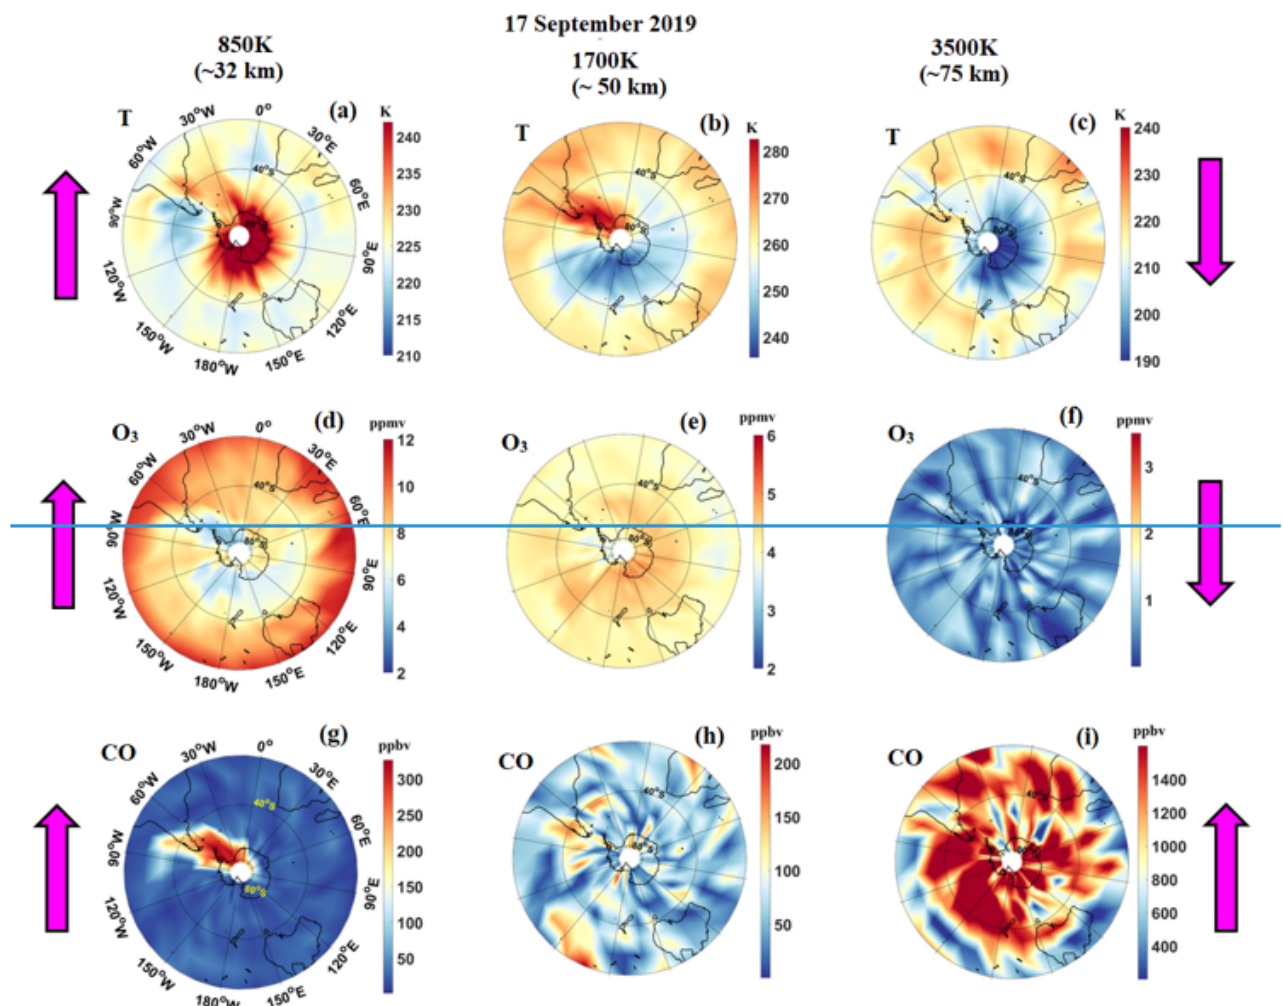
Figure 2. The polar projection of the stratospheric (~32, and 50 km) and mesospheric (~75 km) temperature ( a – c ), ozone (O 3 ) ( d – f ), and carbon monoxide (CO) ( g – i ) during the peak warming day using MLS observations. The maps are shown at different isentropic surfaces (potential temperatures). The upward magenta color arrows show the increasing value, and the downward arrow is indicative of decreasing. To quantify the mesospheric cooling due to CO, the daily variability of CO from MERRA and mesospheric temperatures using MERRA, and MLS over the SH polar region along with the climatological mean and standard deviation, and the variability of the polar mesospheric temperature in response to changes in CO during the SSW period correlation between the mesospheric temperature and CO concentration during the SSW period. CO increased from 25 August and was at its highest level between the